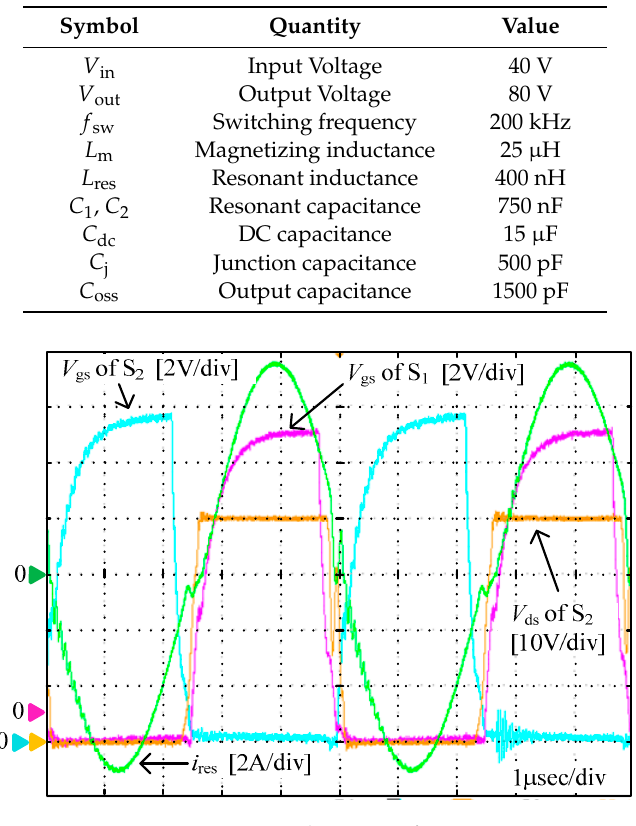
Figure 8. Switching waveforms.